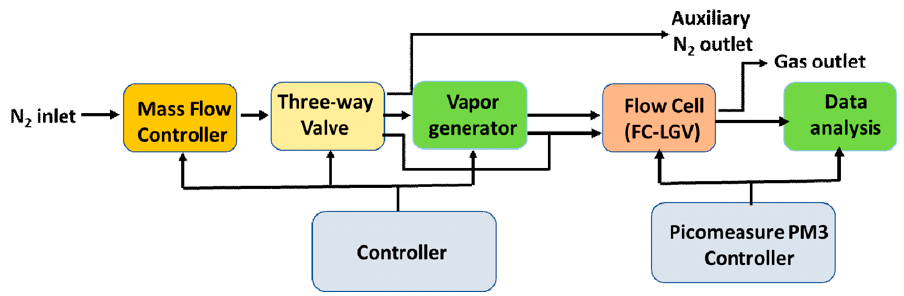
Figure 1. Schematical illustration of the measurement system (Picomeasure PM3).